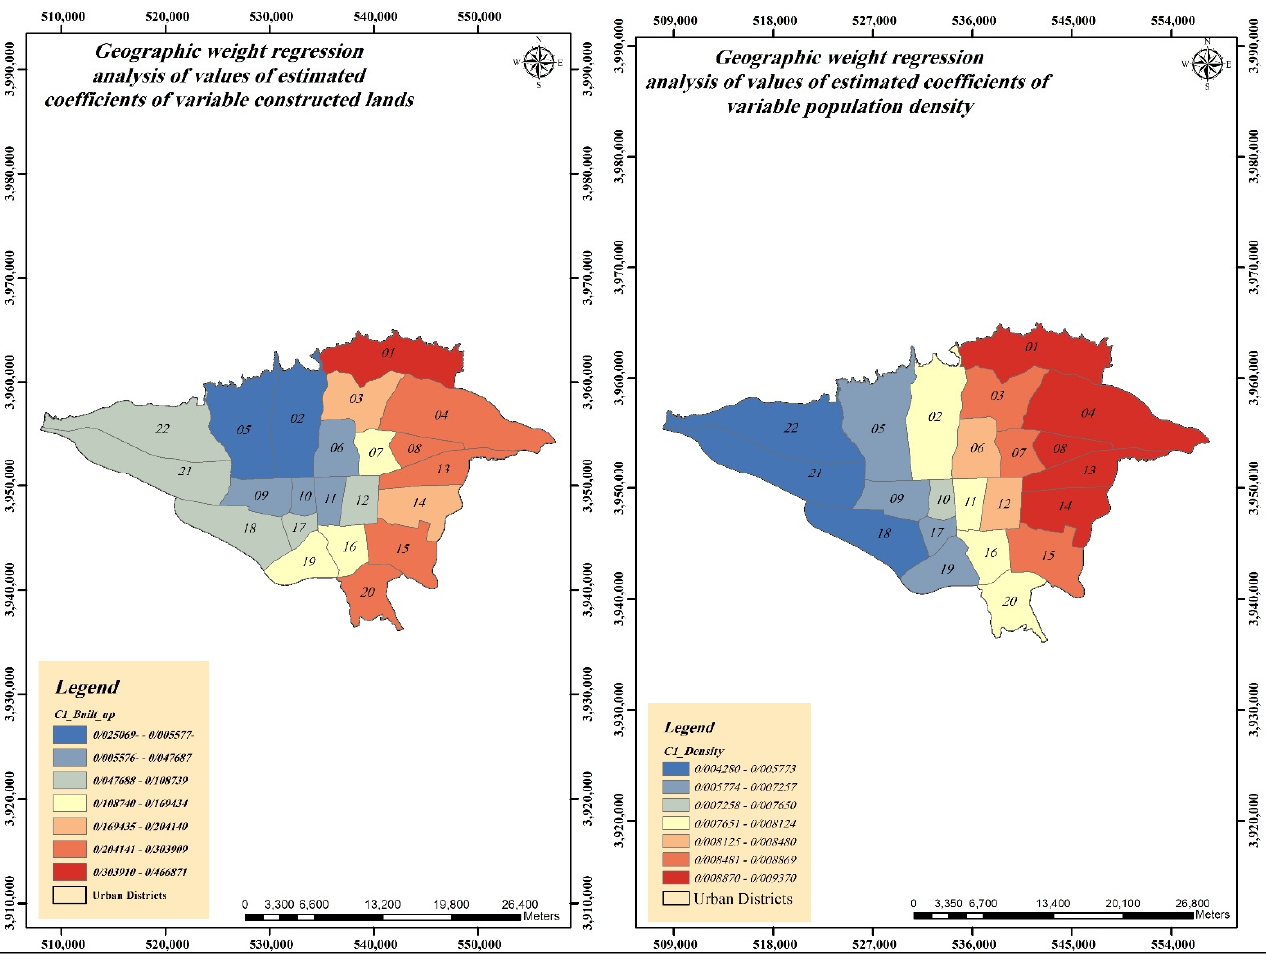
Figure 7. GWR analysis of the values of coefficients estimation of population density variable and constructed lands.